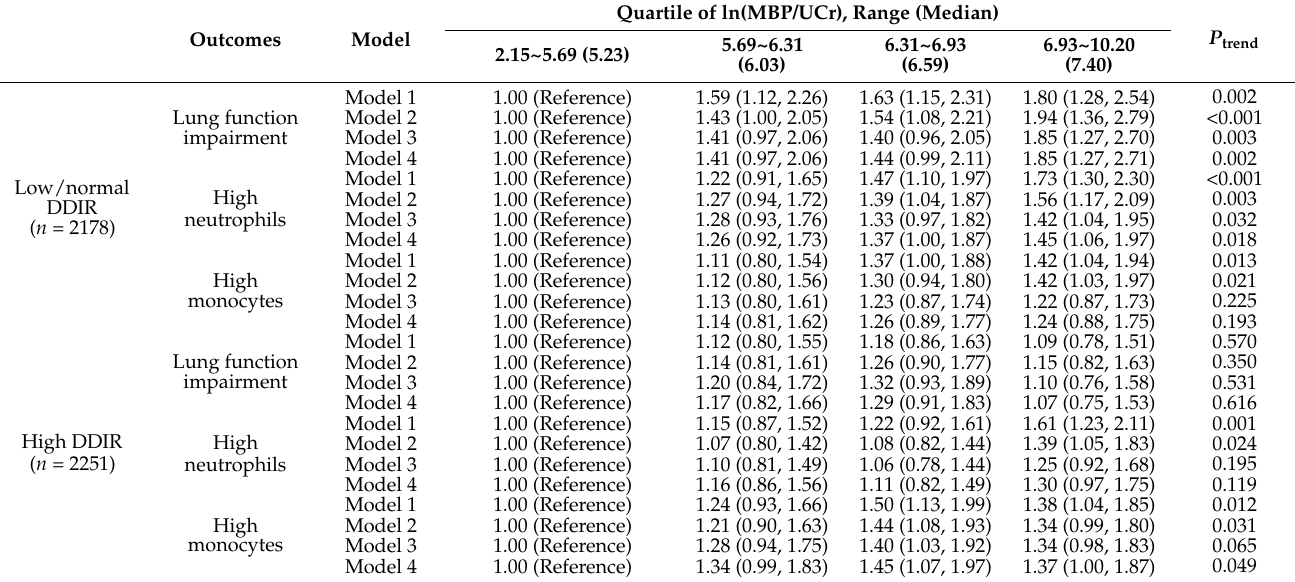
Table 5. Association between urinary MBP and the lung function impairment, neutrophils, and monocytes in different level of daily dietary intake of